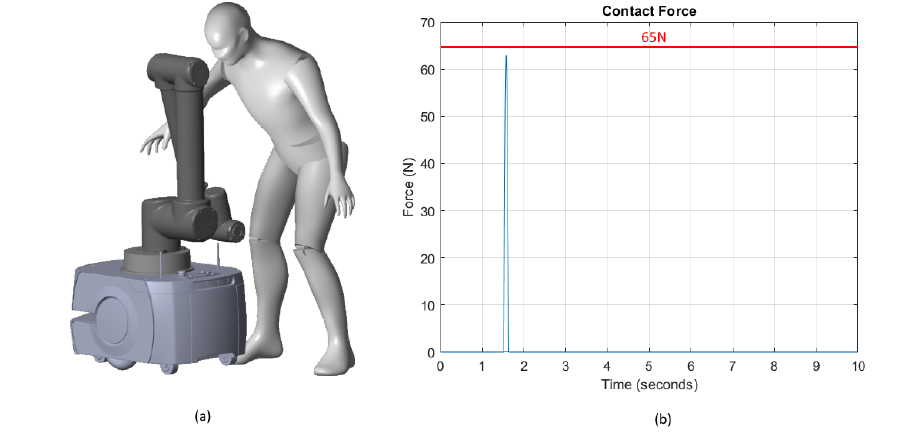
Figure 21. Simscape simulation: ( a ) Simulation of the collision. ( b ) Contact force between cobot and human